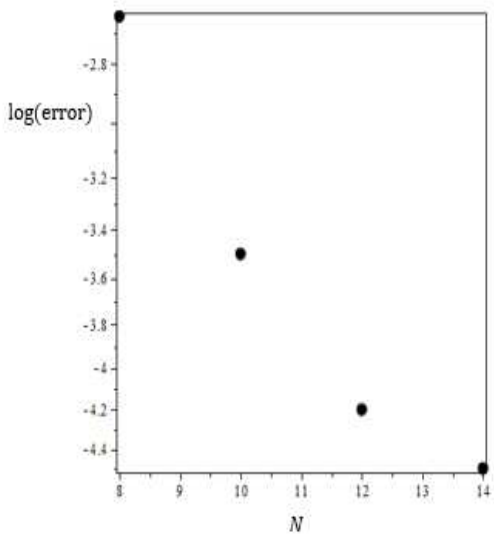
Fig. 5 L 2 error for test problem 2 at w